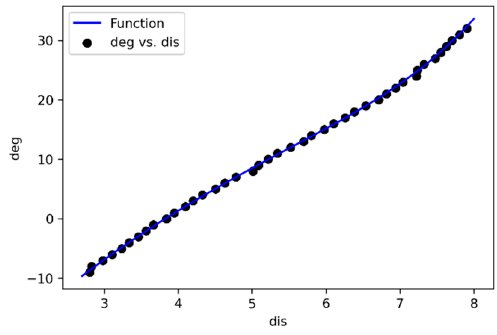
Figure 4. Matlab fitting result.